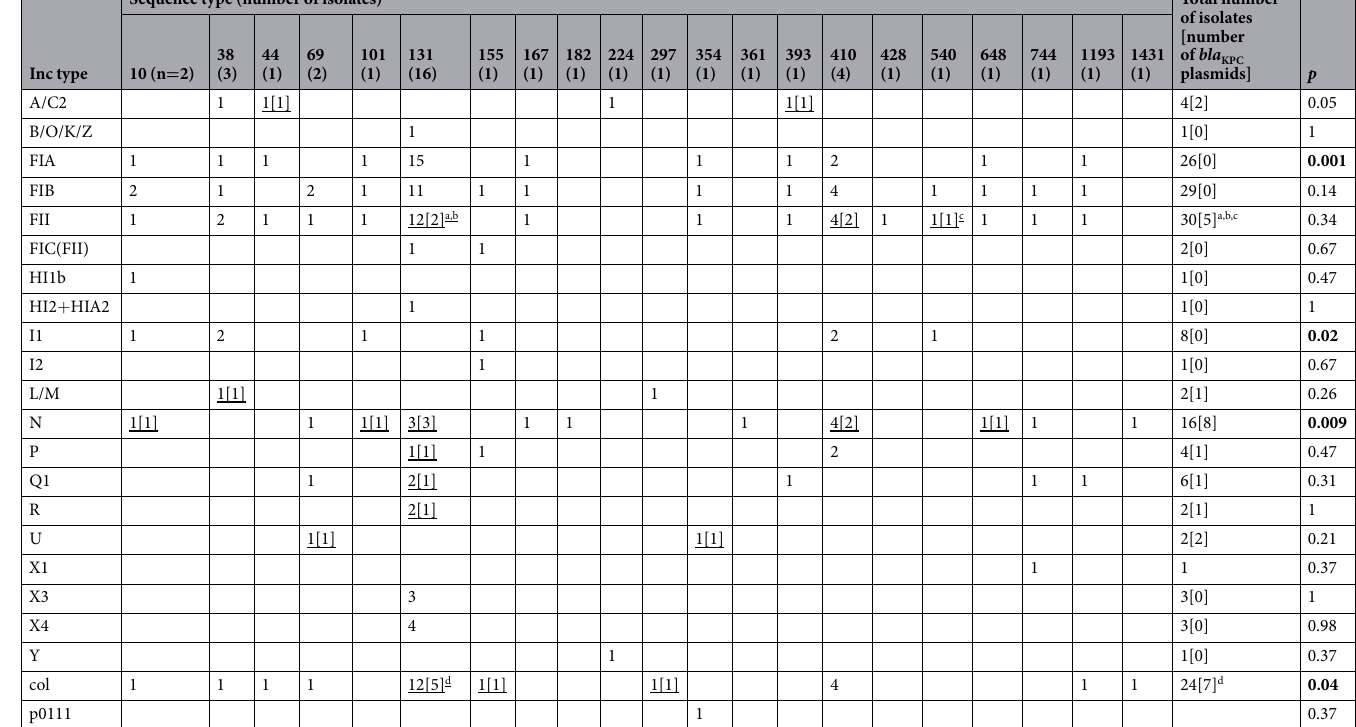
Table 1. Plasmid replicon families present by ST, using the PlasmidFinder database 58 . Undmbers in square brackets represent the known subset of bla KPC plasmids in each cell. Exact test compares presence/absence of each Inc type by ST. The replicon type specifically associated with bla KPC could not be evaluated in 15 isolates, due to limitations of the assemblies. a one multi-replicon plasmid also containing IncFIA. b one multi-replicon plasmid also containing IncFIA and IncR. c one multi-replicon plasmid also containing IncFIB. d one multi- replicon plasmid also containing repA